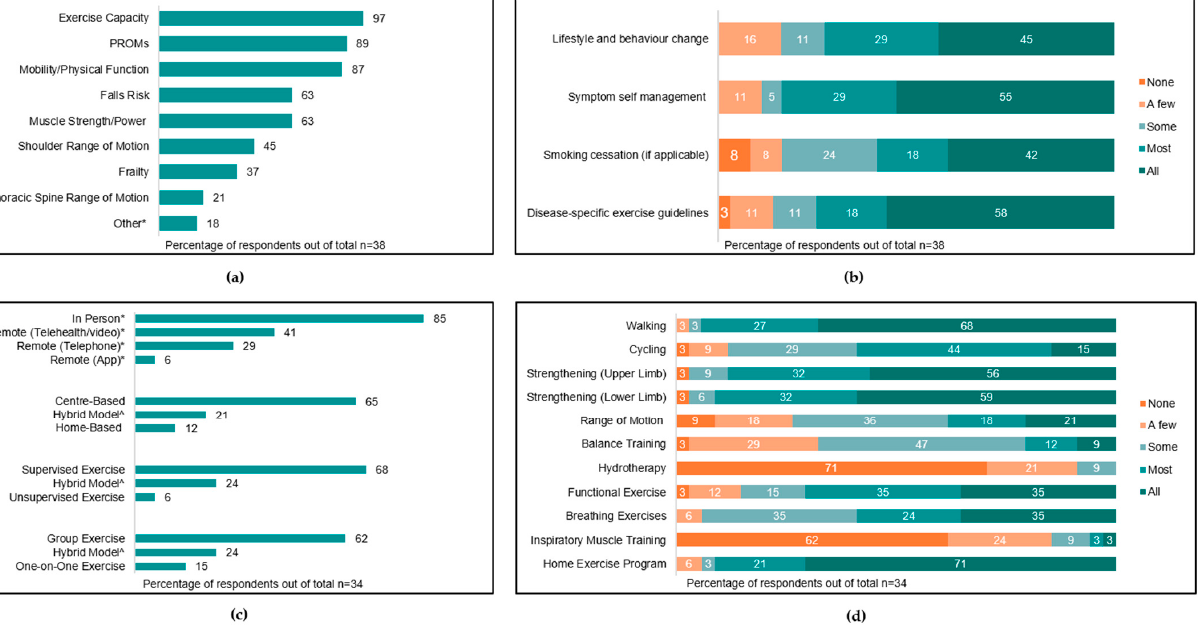
Figure 5. The proportion of people undergoing surgical resection for lung cancer referred to community/outpatient post-operative exercise programs on hospital discharge (%).